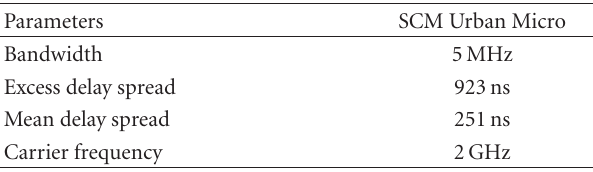
Table 3: “Urban Micro” channel model parameters.